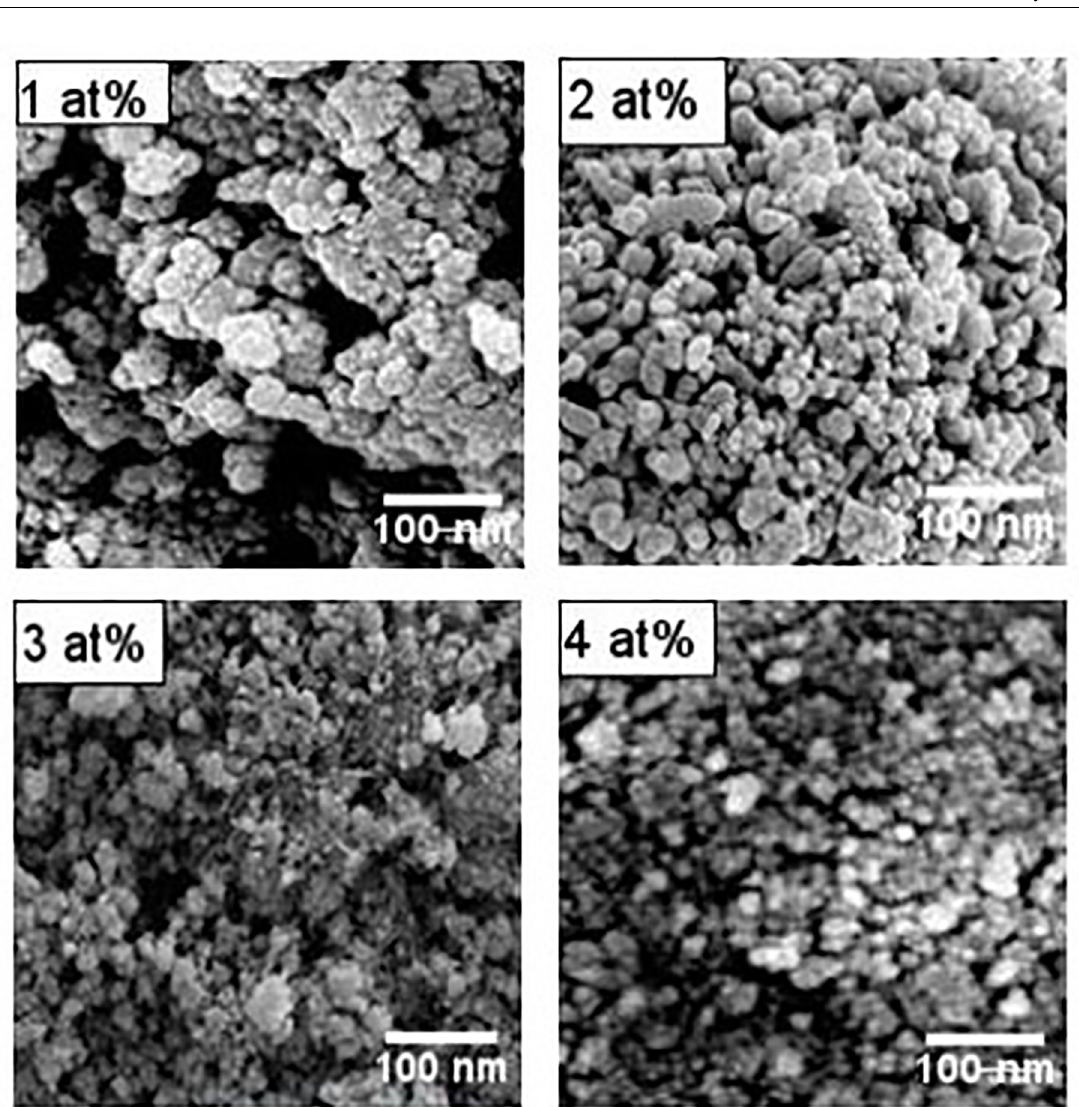
Ca O thin films. Figure 2. SEM images of Ga doped Zn 0.85 0.15 in Table 1. Band gap energy increased with Ga doping in ZnO and Pauli Exclusion Principle restricts states to be concentration due to the increase in carrier concentration singly occupied, valence electrons need additional energy to known as Burstein-Moss (BM) effect. In heavily doped excite to the higher states in the conduction band. According semiconductors, excess electrons occupy levels near the to Burstein, the magnitude of Burstein-Moss shift (ΔE conduction band minimum. As optical transitions are vertical energy gap defined as the shift of Fermi level with